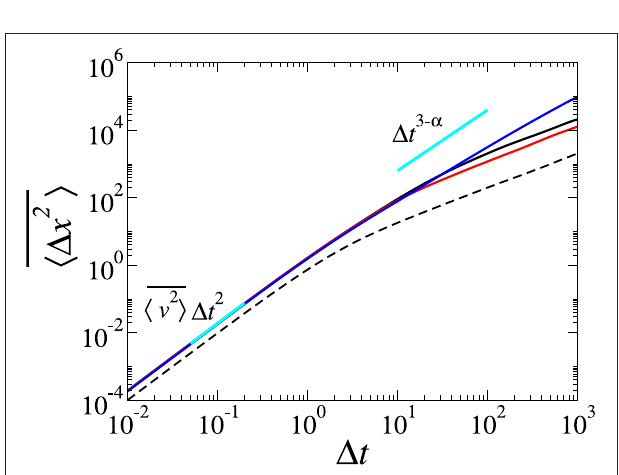
FIGURE 4 | Time-averaged MSDs. The three solid curves correspond to the case of P ( τ ), respectively, the poissonian (black), gaussian (red), and the power-law (blue). For reference, the underdamped Brownian particle with f ( t ) 0 is plotted together (dashed). Additionally, the theoretical expectation = v 2 1 t 2 , Equation 18, is overlaid with the simulation data. The (thick cyan) of h i simulations were carried out based on the equation of motion 1 with v 0 timestep δ t 0.01, and with 10 5 random realizations of f ( t ). The same = parameter values used in Figure 3 . The basic units are: [ x ] m / ( βσ [ t ] = p